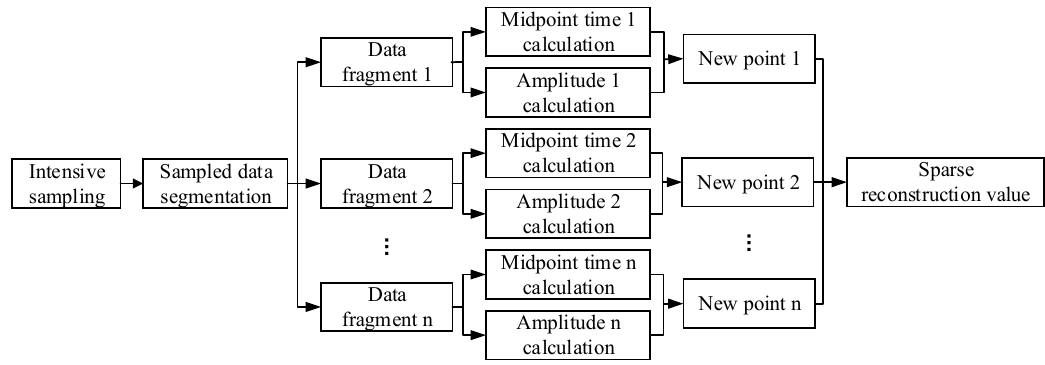
Figure 3. Schematic diagram of intensive sampling sparse reconstruction.